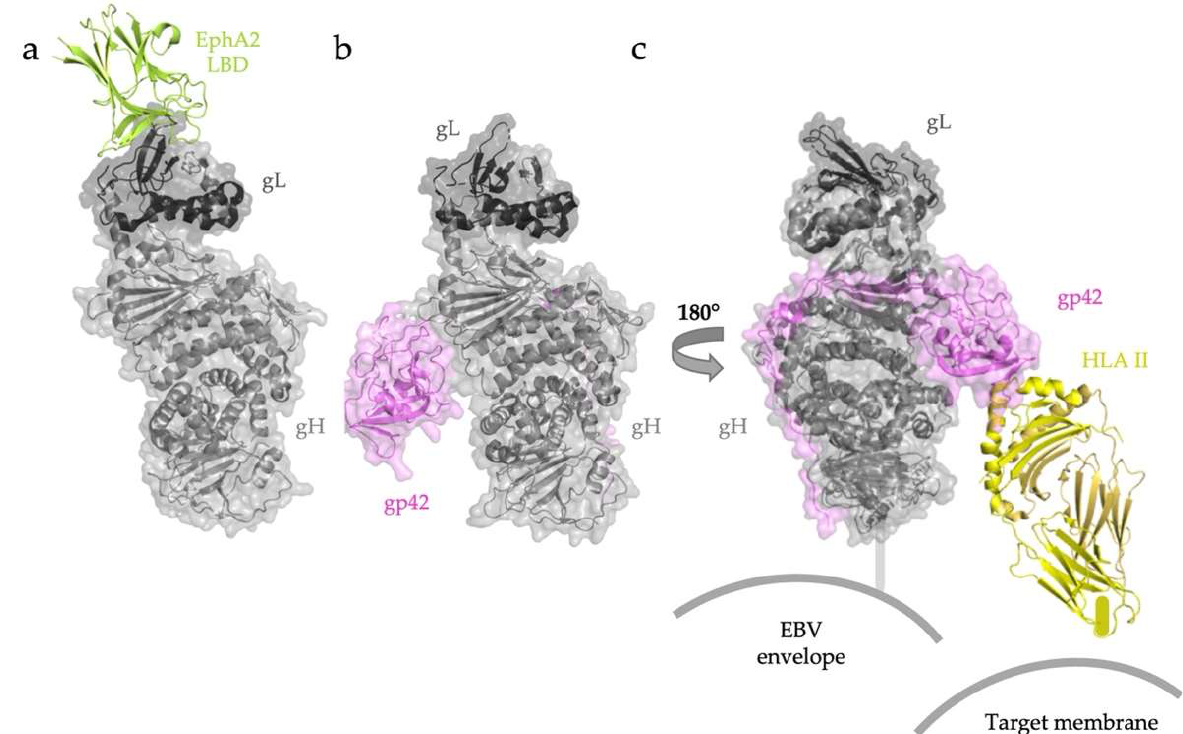
Figure 4. EBV gH/gL recognizes target cell receptors in adaptor-independent and adaptor-dependent ways. ( a ) Both EBV and KSHV (not shown) attach to epithelial cells by binding the EphA2 LBD through extensive contacts with gL. ( b ) Overall architecture of the EBV gH/gL-gp42 complex. ( c ) Interactions with B-cell HLA II are mediated by the globular C-terminal domain of gp42. Once this receptor is engaged, a change in the angle between HLA II and gH/gL has been proposed to trigger fusion. RCSB PDB ID: EBV gH/gL/EphA2 (7CZE) [32]. The structure of EBV gH/gL/gp42/HLA II